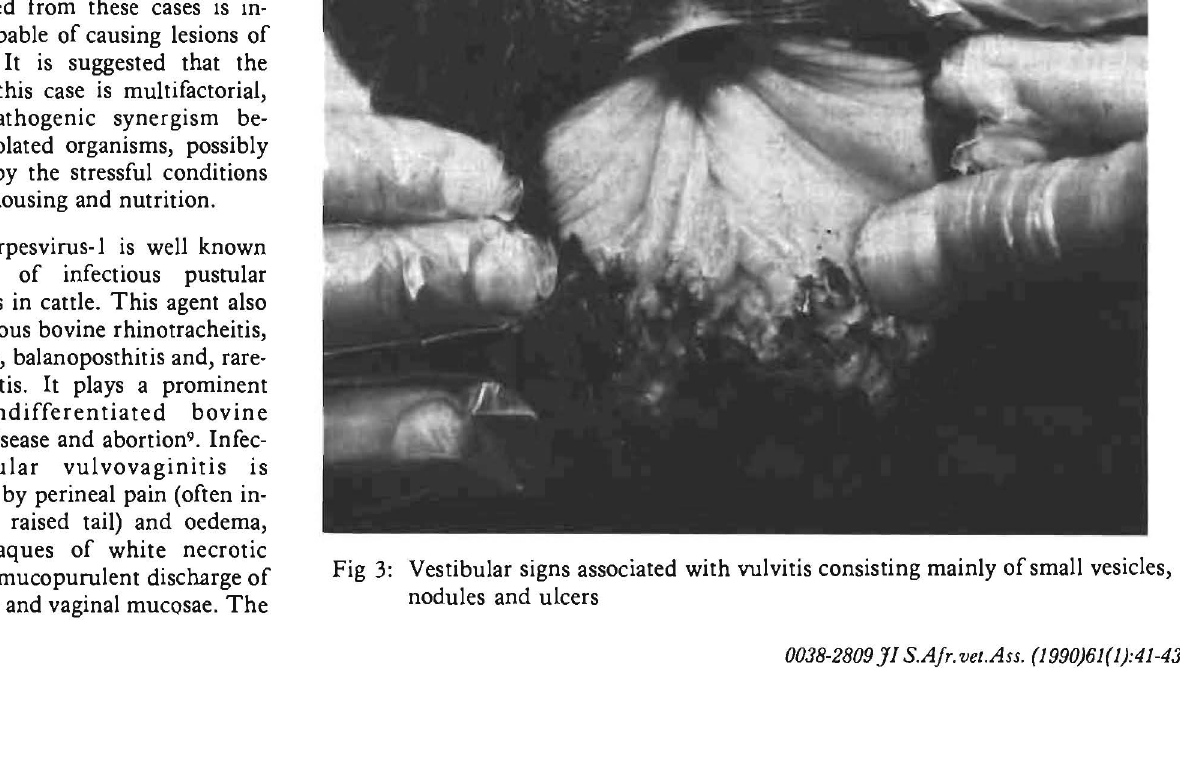
pneumonic pasteurellosis by infectious bovine rhinotracheitis virus has been postulated to result from impairment of cellular immune mechanisms by the virus with res).litant diminished